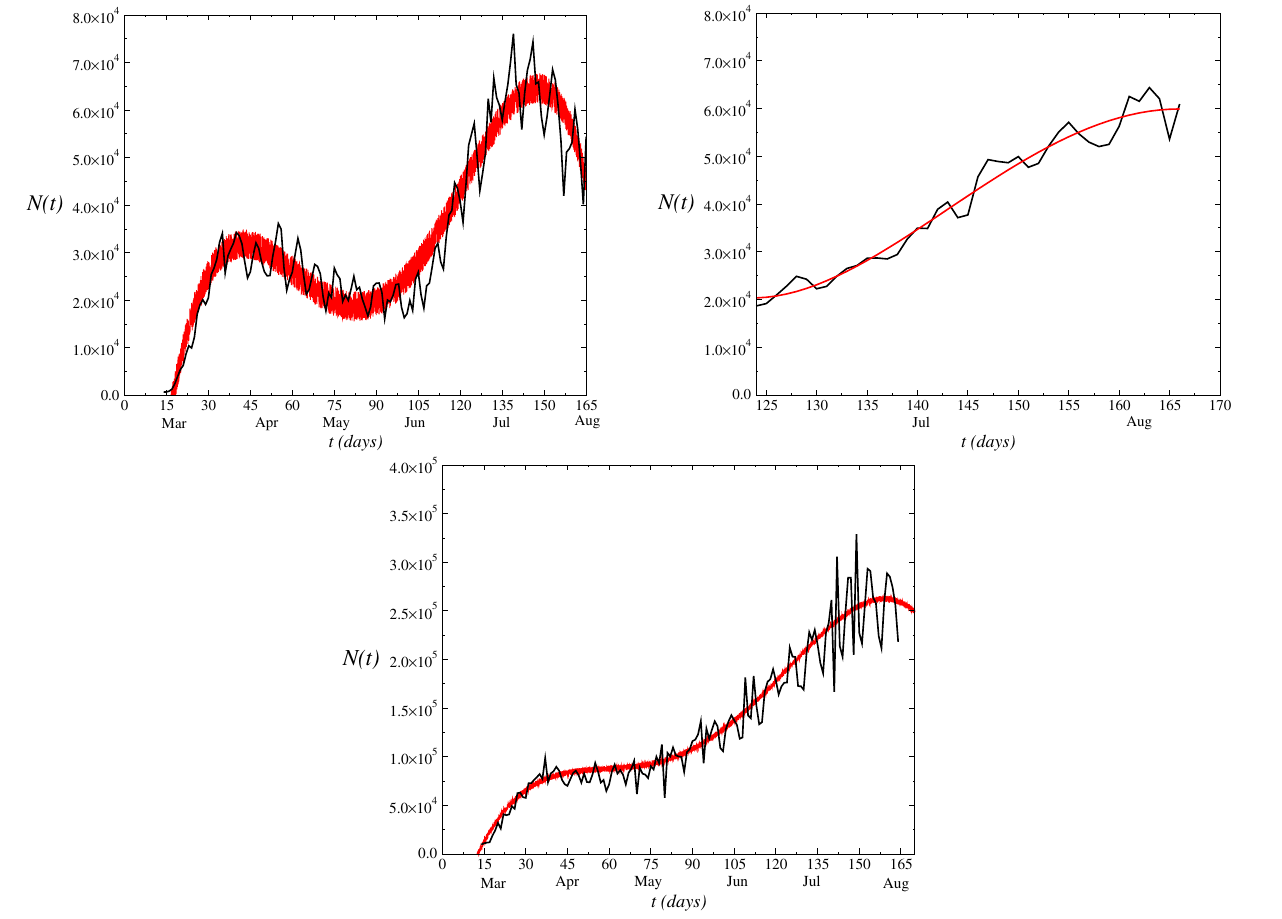
Figure 3. Dynamics of novel cases N ( t ) in United Sates (left), India (Center) and all world (right) and the correspondent time series obtained for each model Eq. (2). The data were obtained for values α 0.0625 , noise amplitude Ŵ η =